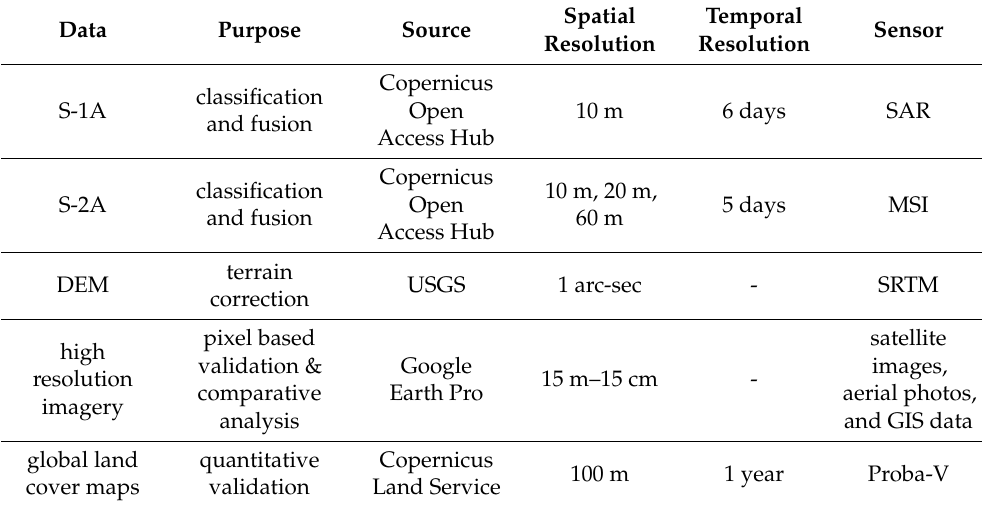
Table 1. Datasets used in the study with specifications.